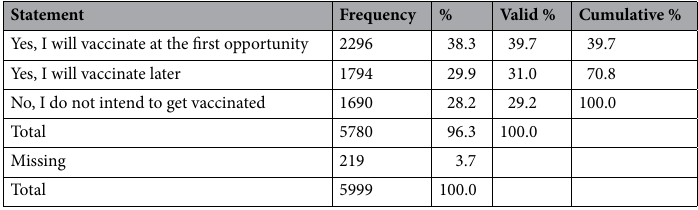
Table 2. Intentions of postsecondary students to be vaccinated.